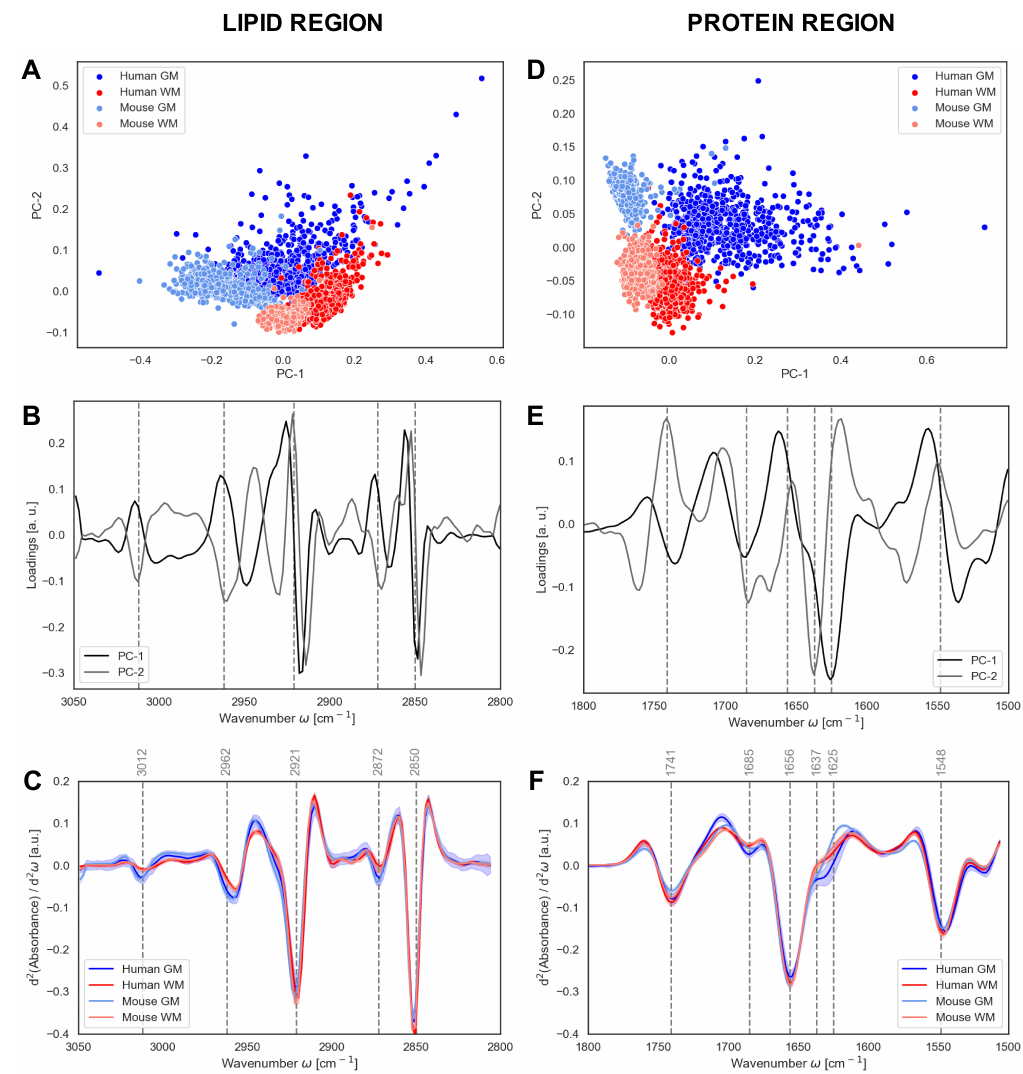
Figure 3. Principal Component Analysis (PCA) of grey matter (GM) and white matter (WM). PCA of the normalized second derivatives of the lipid region (3050–2800 cm − 1 ) and protein region (1800–1500 cm − 1 ), showing the scores plots ( A , D ), the resulting loadings for PC-1 and PC-2 ( B , E ) and the average spectra ( C , F ) of the two regions, respectively. Spectra shadowing in C and F indicates standard deviation. a.u.—arbitrary units.